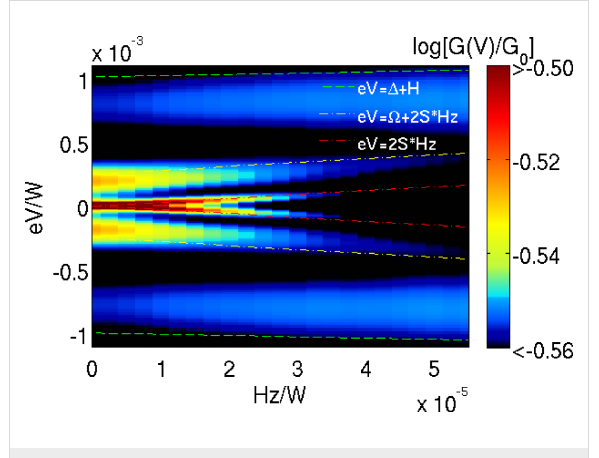
Figure 5: Magnetic field evolution of the differential conductance normalized to G 0 (log color scale) for the parameters of the red curve of Figure 3: S = 3/2, E = 0.02 D , D ′ = 0.04 D and E ′ = 0.16 D . Dashed lines mark the QST-Kondo (red) and vibrational side-peak (yellow) both evolving with an anomalous g -factor and zero-field, split, high- spin Kondo peak (blue).